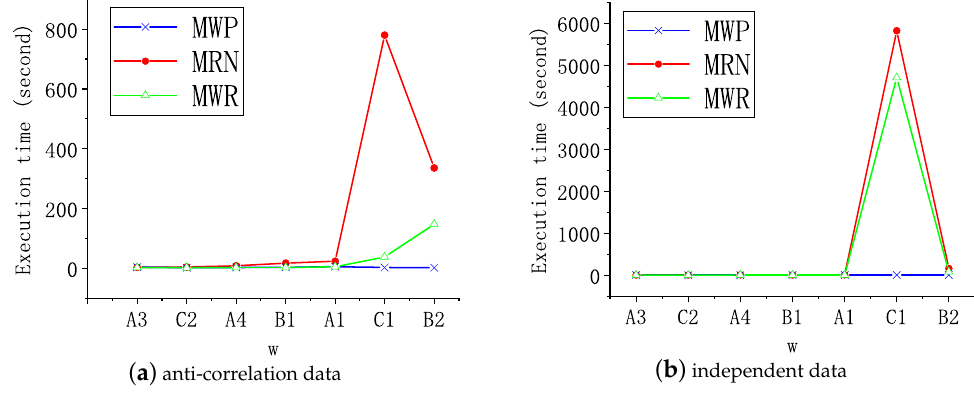
Figure 11. Execution time for the MRE algorithm, where w (cid:54)∈ R